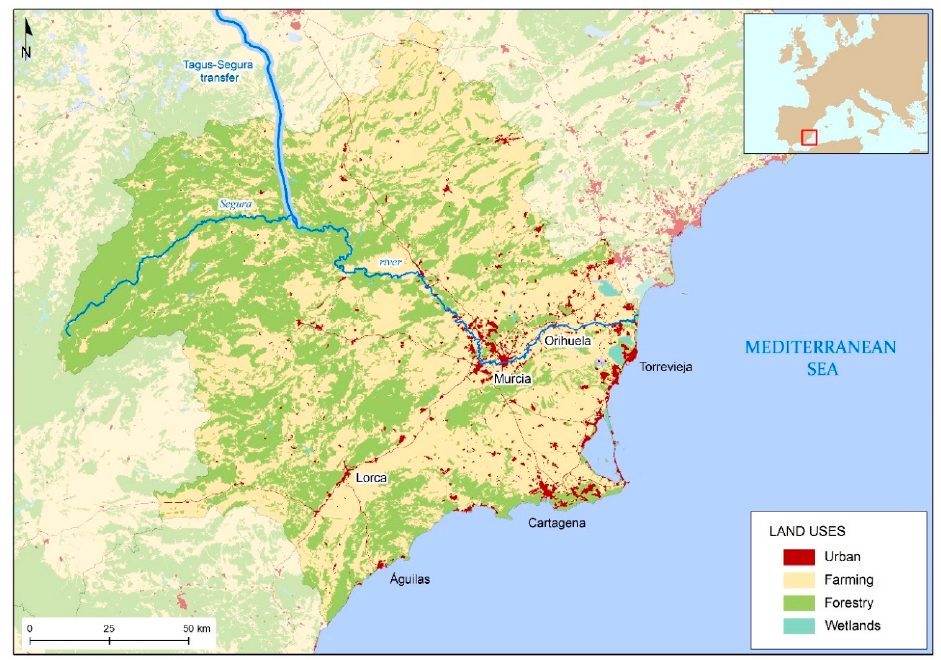
Figure 1. Location and main land uses of the Segura River Basin. Own elaboration.